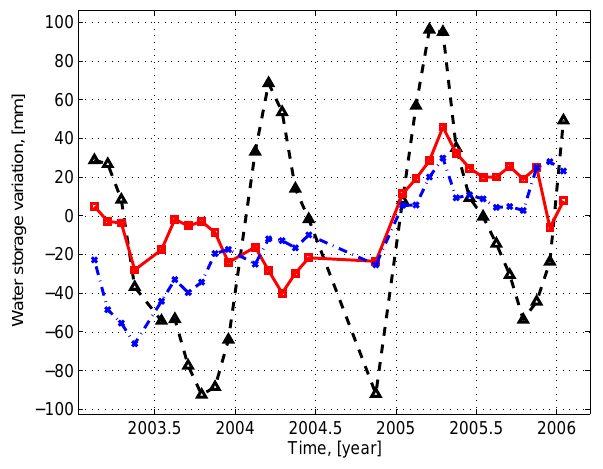
Fig. 10. Differences of water storage variations from LEW and GRACE for the period January 2003 until December 2005. Up- per Zambezi target area. Gaussian filter with 1000km correlation length. Black triangles: LEW – GRACE; red squares: LEW – GRACE/LEW; blue crosses: LEW-GRACE/CPC